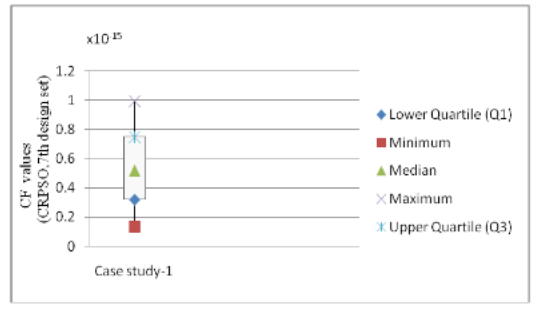
Figure 8: Plot of ( W / L ) n versus iteration cycle for the eighth design set of CRPSO for Case study-3.